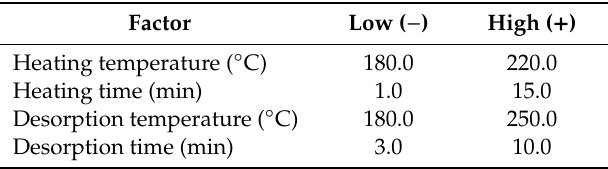
Table 1. Levels of the 2 4 factorial